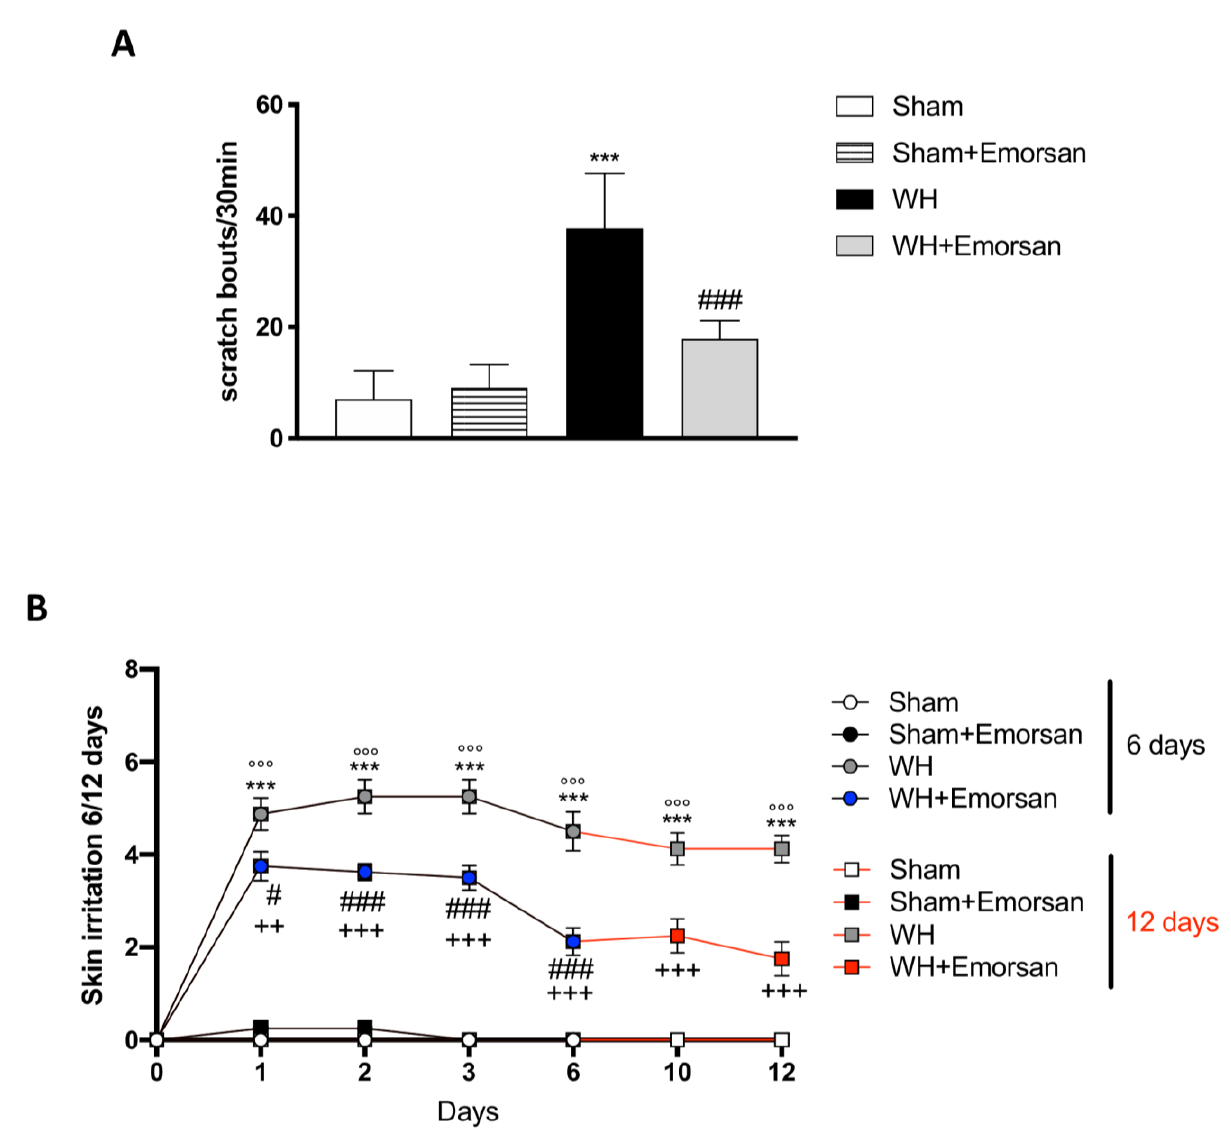
Figure 5. Effect of Emorsan ® Gel administration on itch-induced scratching and skin irritation. An increase in scratch bouts was detected in WH mice compared to sham animals ( A ); conversely, Emorsan ® Gel treatment was effective in reducing itch-induced scratching ( A ). Moreover, Emorsan ® Gel administration decreased skin irritation until 6 days and 12 days after WH induction ( B ). Data are representative of at least three independent experiments. Values are means ± SEM. One-Way ANOVA test. *** p < 0.001 vs. Sham 6 days; °°° p < 0.001 vs. Sham 12 days; # p < 0.05 vs. WH 6 days; ### p < 0.001 vs. WH 6 days; ++ p < 0.01 vs. WH 12 days; +++ p < 0.001 vs. WH 12 days.